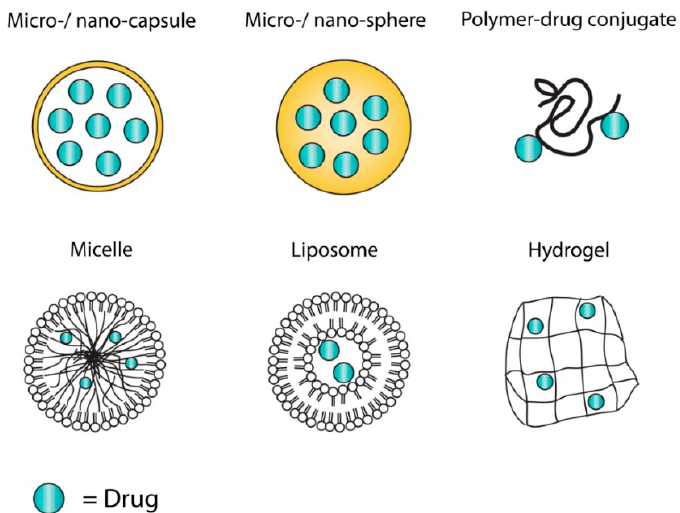
Figure 3. Different structures of drug delivery systems (not-exhaustive). Each structure has its advantages and disadvantages to incorporate and release different types of drugs. Reproduced with permission from [18]; published by MDPI, 2014.